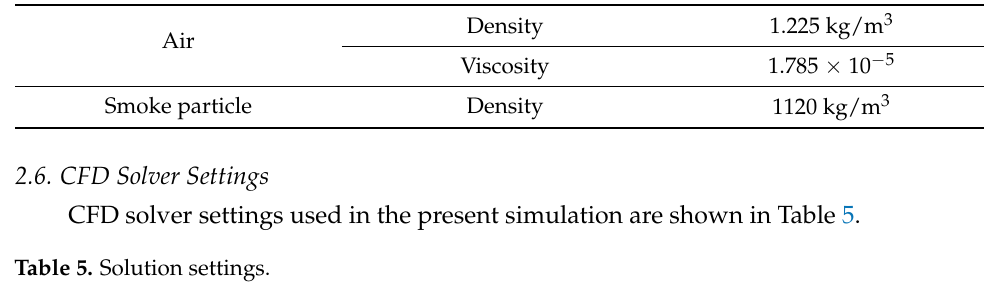
Table 4. Material properties.